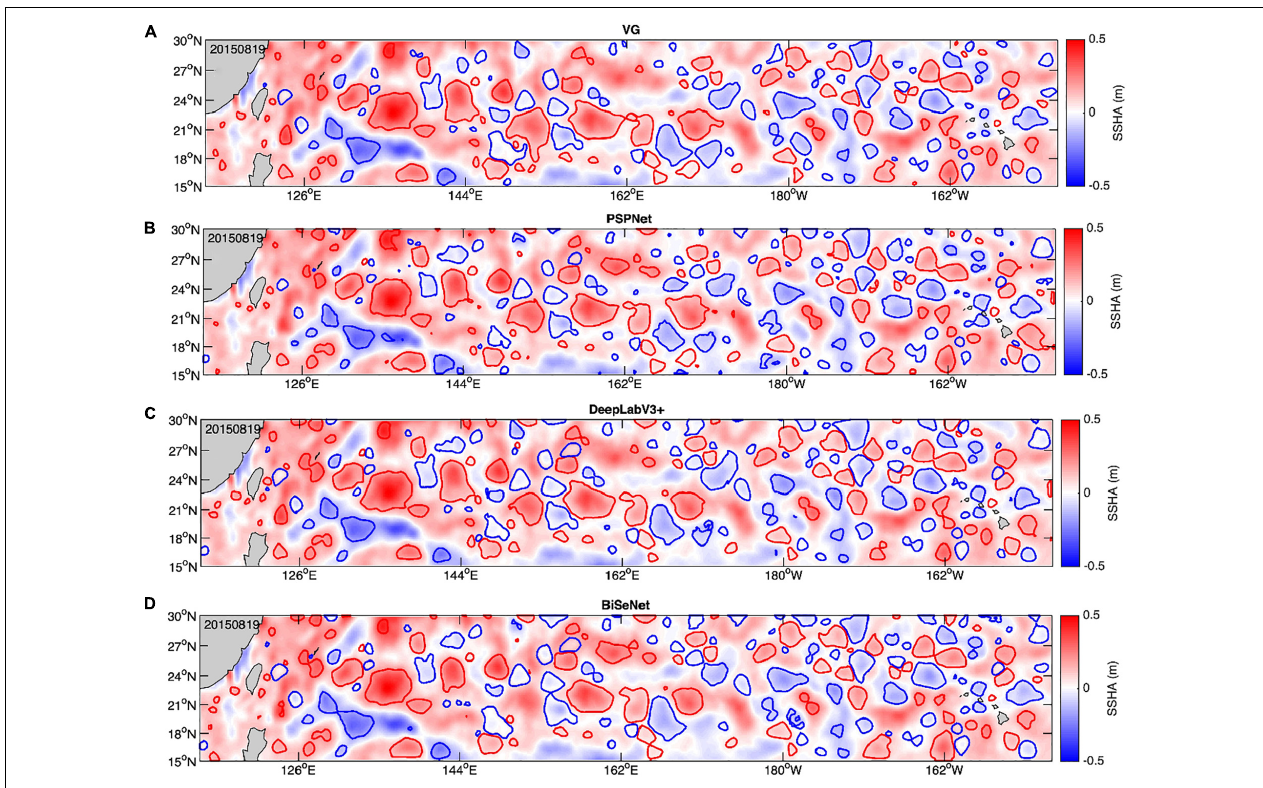
FIGURE 4 | Oceanic eddies identified by VG (A), PSPNet (B), DeepLabV3+ (C) , and BiSeNet (D) algorithms in the STCC region on 19 August 2015.